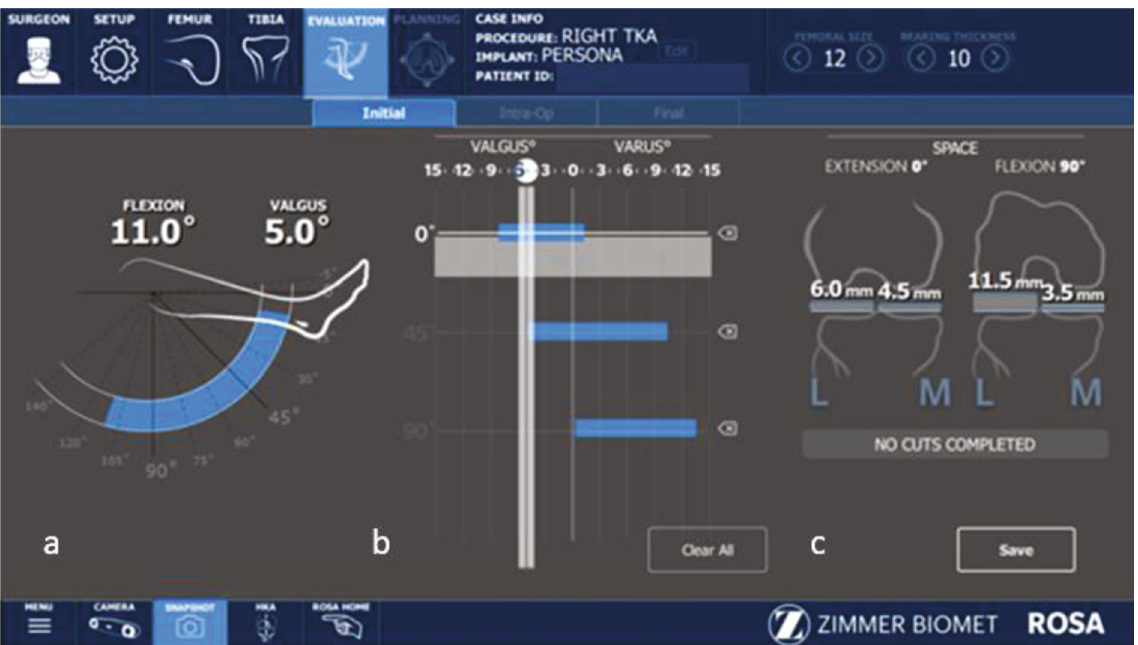
Figure 14: Initial evaluation of the knee for Case 4 including (a) ROM, (b) alignment, and (c) joint space